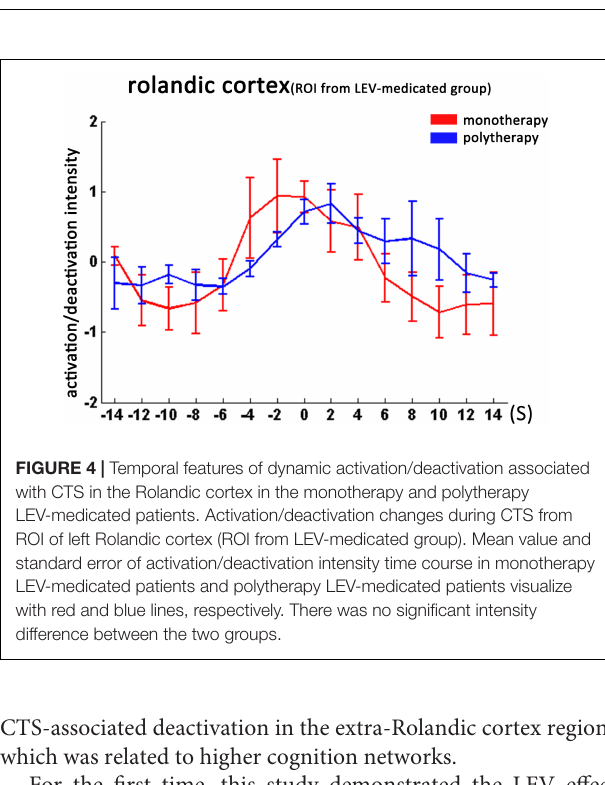
FIGURE 3 | Temporal features of dynamic activation/deactivation associated with CTS in the Rolandic cortex and other brain regions in the drug-naive and LEV-medicated patients. Activation/deactivation changes during CTS from ROIs of the bilateral Rolandic cortex, left Rolandic cortex, posterior cingulate cortex (PCC), bilateral dorsolateral prefrontal cortex (dlPFC), and bilateral intraparietal sulcus (IPS). Mean value and standard error of activation/deactivation intensity time course in drug-naive patients and levetiracetam (LEV)-medicated patients visualize with red and blue lines, respectively. (A) In the bilateral Rolandic cortices (ROI from the drug-naive group), the LEV-medicated group showed earlier time-to-peak (time point -2 s) compared with the drug-naive group (time point 0 s). Moreover, the LEV-medicated group showed lower peak intensity and relatively rapid decline, resulting in lower activation intensity from 0 to +8 s overall ( p < 0.05, with no correction). (B) In the left Rolandic cortex (ROI from the LEV-medicated group), there was no significant intensity difference between the two groups (C–E) . In the PCC, dlPFC, and IPS, the LEV group showed higher activation intensity compared with the drug-naive group before the CTS onset from -6 to -2 s, -4 to 0 s, -4 to 0 s, respectively. ( p < 0.05, with no correction). ∗ p < 0.05, ∗ p < 0.01. LEV, levetiracetam; PCC, posterior cingulate cortex; dlPFC, dorsolateral prefrontal cortex; IPS, intraparietal sulcus.